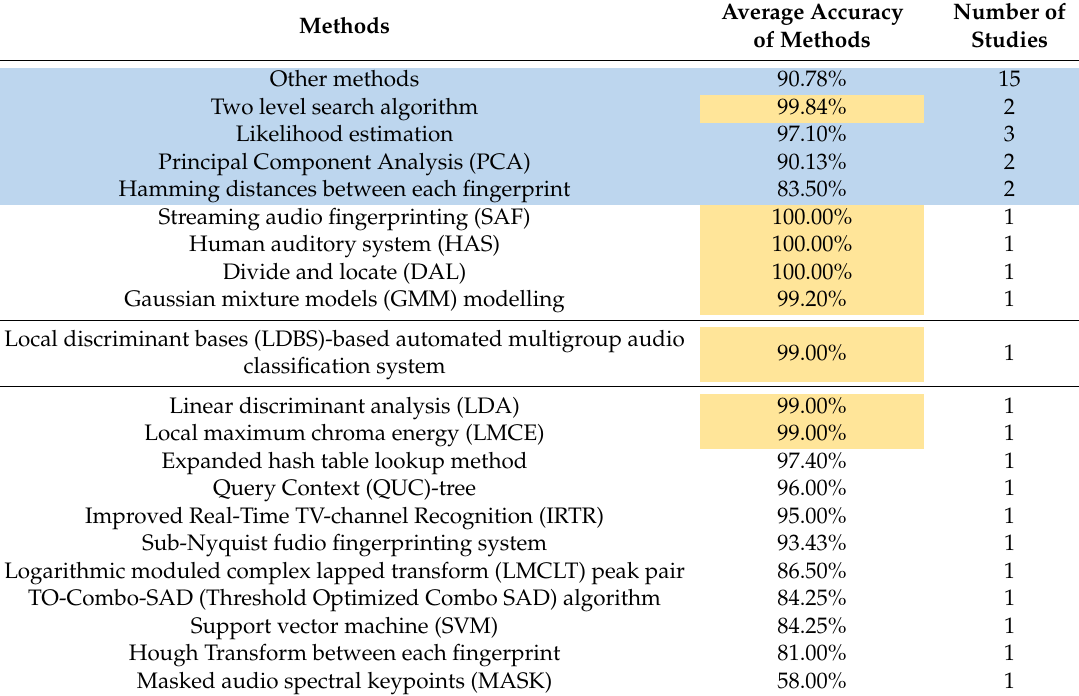
Table 4. Distribution of the methods implemented in the